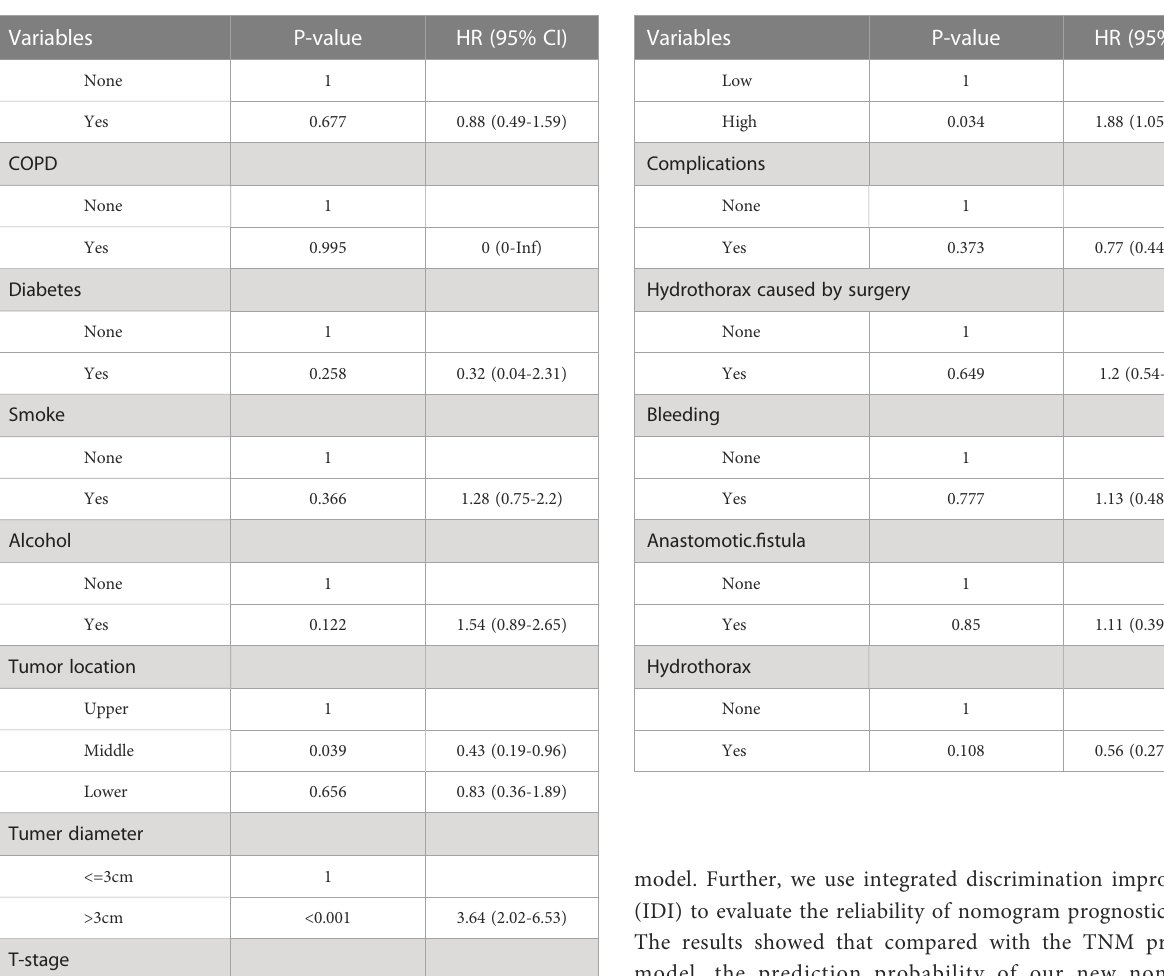
(IDI) to evaluate the reliability of nomogram prognostic model. The results showed that compared with the TNM prognosis model, the prediction probability of our new nomogram prognostic model improved by 6.0% (P =0.040) at the fi rst year, 4.2% (P =0.079) at the third year, and 5.4% (P =0.048) at the fi fth year (Figures 8A –